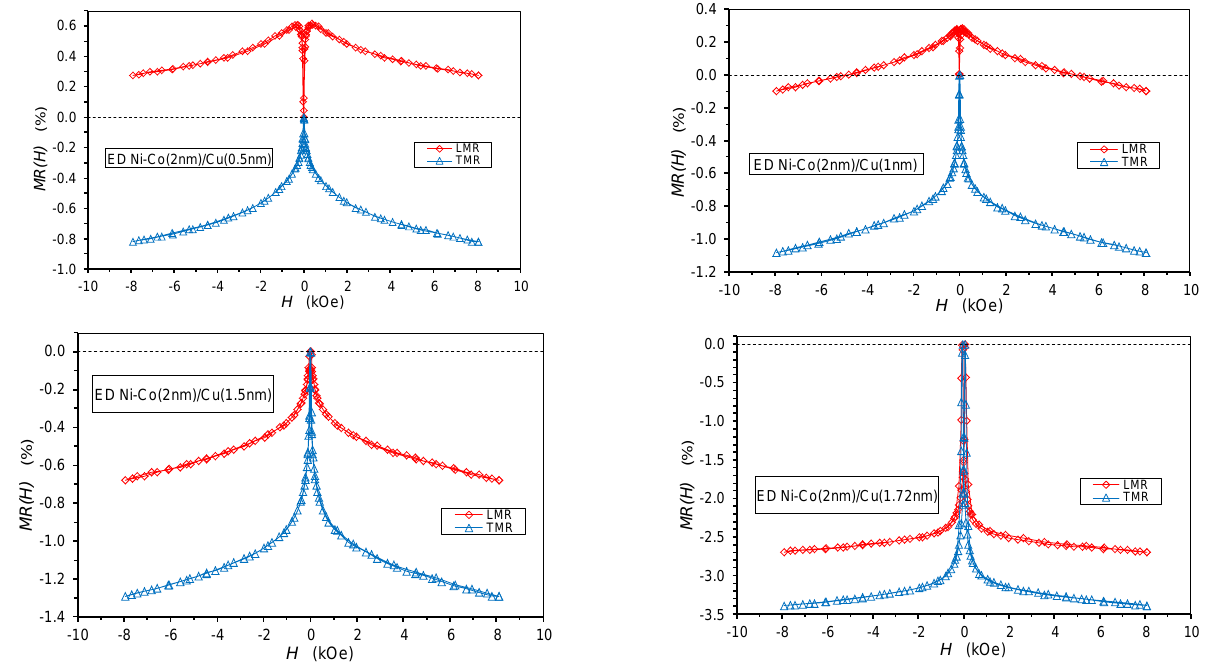
Figure 12. MR( H ) curves for the four Ni-Co/Cu multilayers with the thinnest Cu layers: t Cu = 0.5 nm ( upper left panel ), 1 nm ( upper right panel ), t Cu = 1.5 nm ( lower left panel ) and t Cu = 1.72 nm ( lower right panel ).